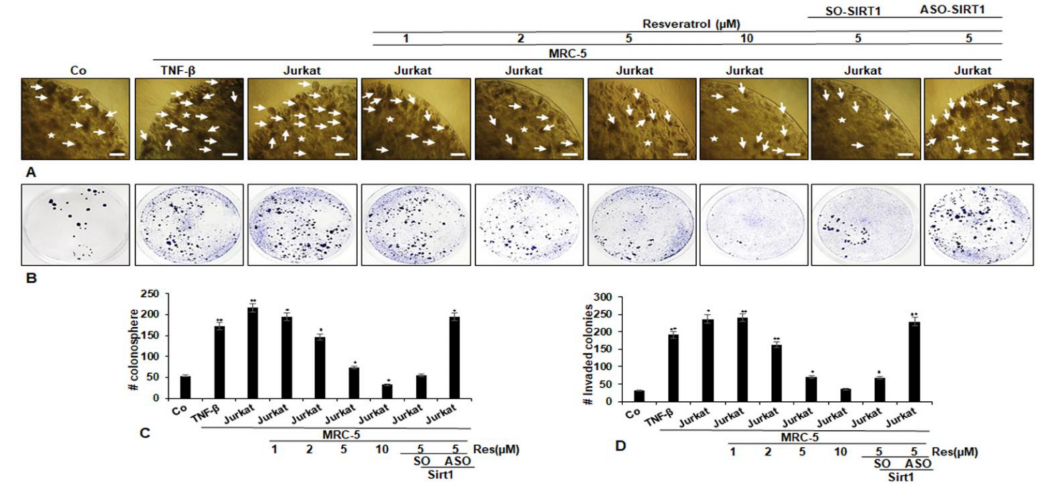
Figure 3. Impact of resveratrol and Sirt1-ASO on CRC cell colony formation and invasion in the multicellular-TME. Serum-starved cultures of HCT116 cells in 3D alginate cultures alone (basal control = co) or co-cultured with fibroblasts and TNF- β (10 ng / mL) (TNF- β -TME) or co-cultured with fibroblasts and T-lymphocytes (pro-inflammatory multicellular-TME) were either left untreated, or multicellular-TME cultures were treated with various doses of resveratrol (1, 2, 5, 10 µ M), or transfected with 0.5 µ M sense oligonucleotide (SO) control, or antisense oligonucleotides (ASO) against Sirt1 in the presence of Lipofectin transfection reagent (10 µ L / mL) and co-treated with resveratrol (5 µ M) for 14 days in alginate cultures (asterisks), as described in the Materials and Methods section. Colonosphere formation ( A ) and invasion ( B ) were evaluated by light microscopy. All experiments were performed at least three times. The number of colonospheres (arrows) and invaded colonies was quantified ( C , D ) by counting 20 di ff erent microscopic fields, and the number of attached colonies stained with toluidine blue, were quantified in each well. * p < 0.05, ** p < 0.01 relative to basal control. Magnification A: × 24, bar = 0.2